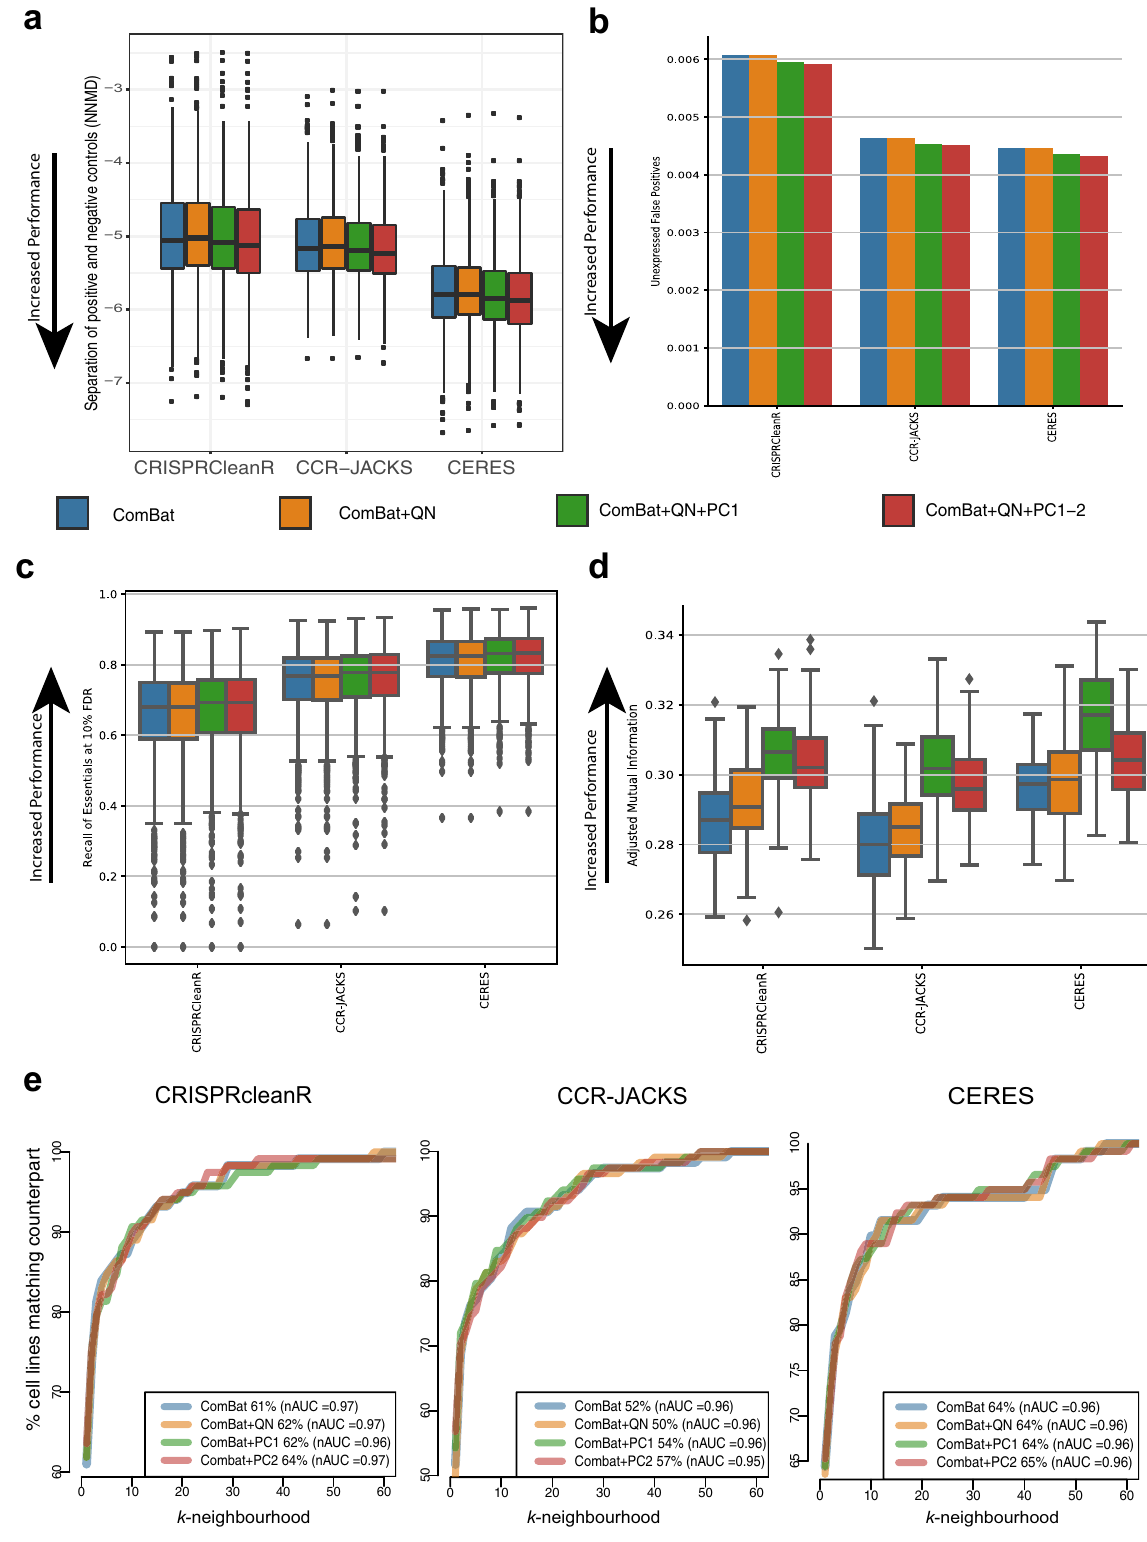
improvement with the removal of one or two principal components (Fig. 4e). The normalized area under the curve (nAUC) values showed little variation across batch correction methods and were broadly similar between the pre-processing methods CERES (lung = 0.96, breast = 0.91 − 0.92), CCR-JACKS